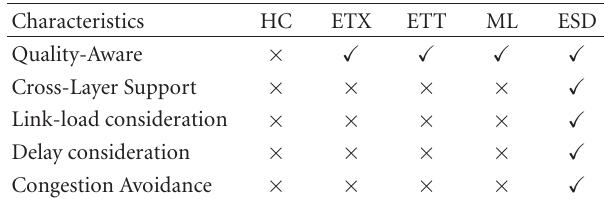
Table 1: Comparison of Routing